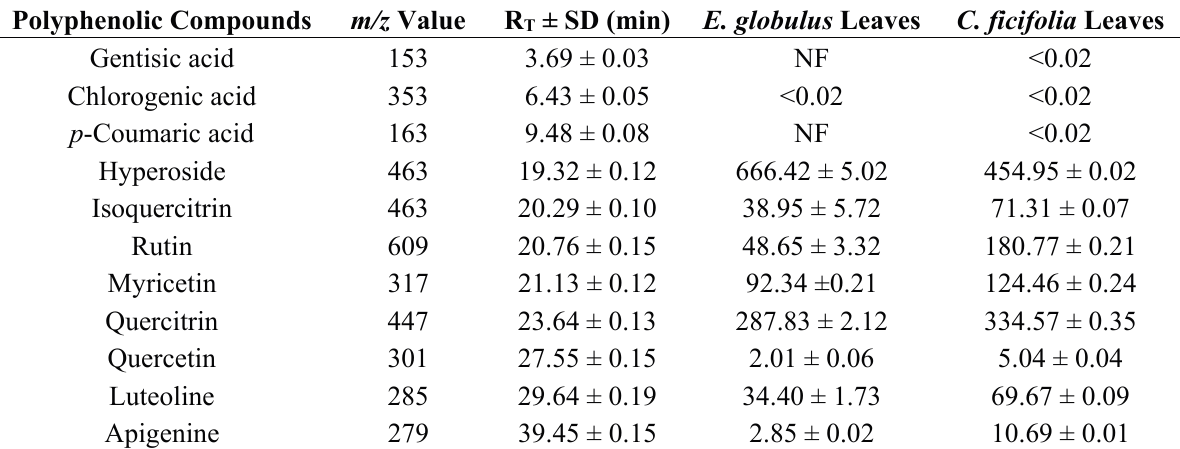
Table 1. The polyphenolic compounds content in the natural products ( μ g/g dw plant material). Polyphenolic